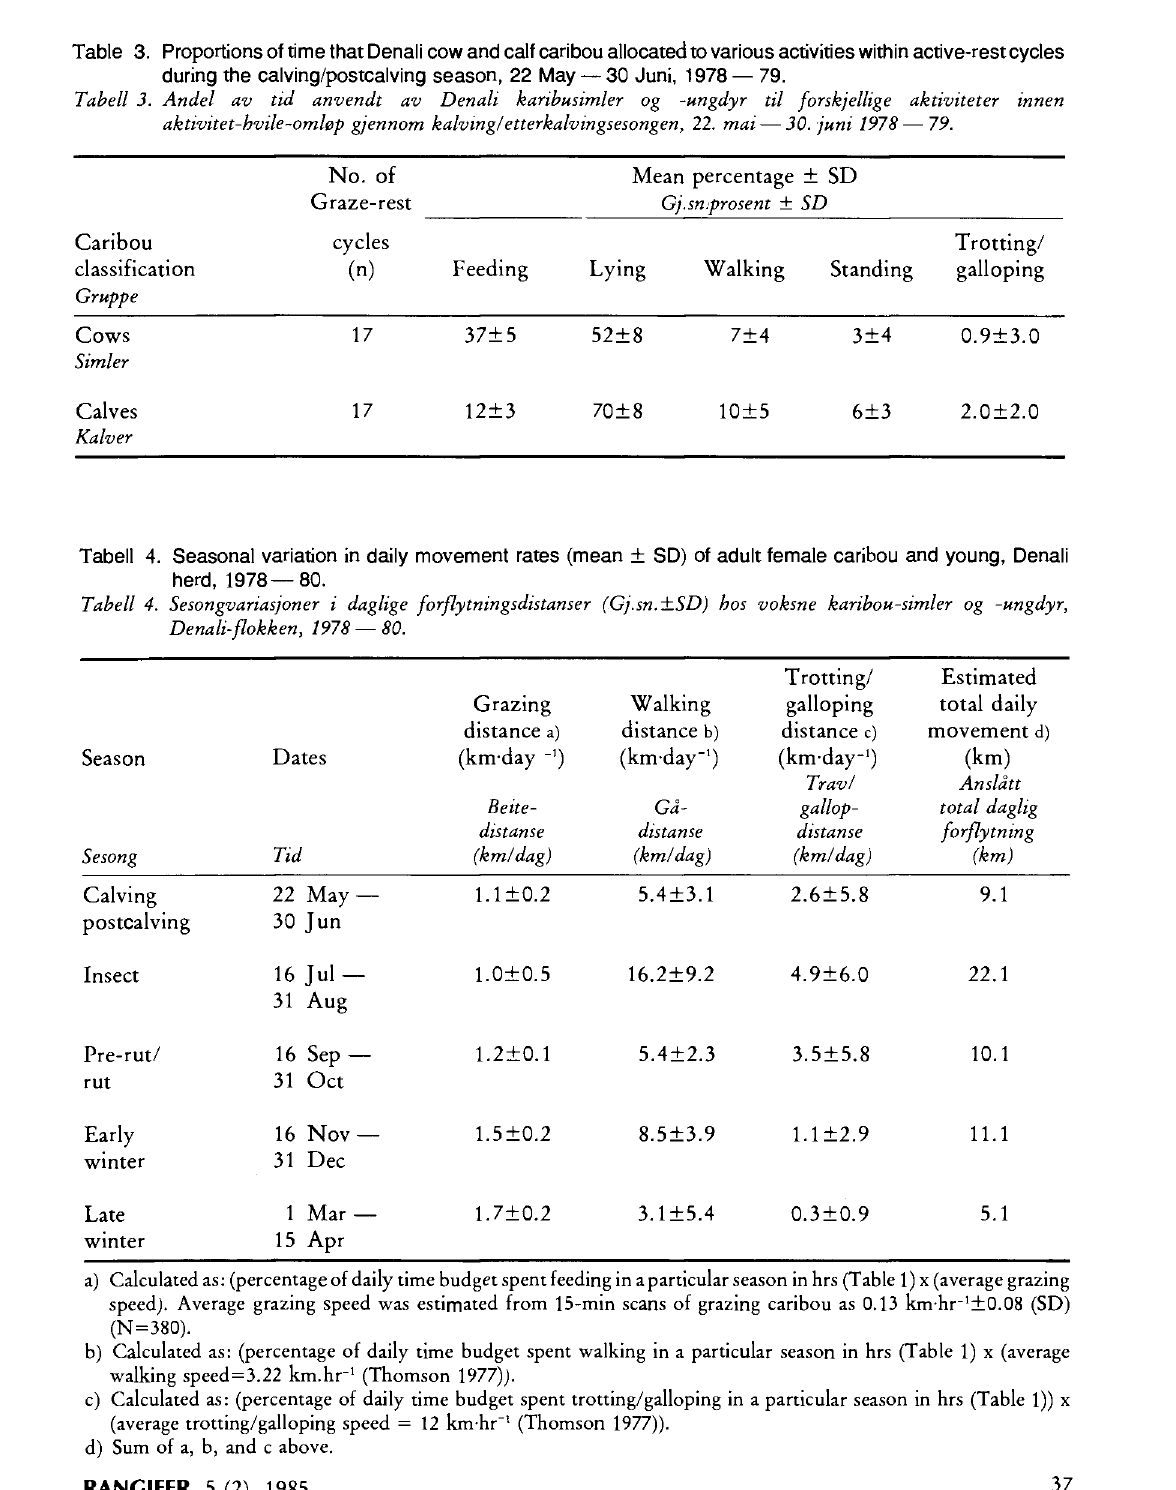
Table 3. Proportions of time that Denali cow and calf caribou allocated to various activities within active-rest cycles during the calving/postcalving season, 22 May — 30 Juni, 1978 — 79. Tabell 3. Andel av tid anvendt av Denali karibusimler og -ungdyr til forskjellige aktiviteter innen aktivitet-hvile-omløp gjennom kalving/etterkalvingsesongen, 22. mai — 30. juni 1978 —